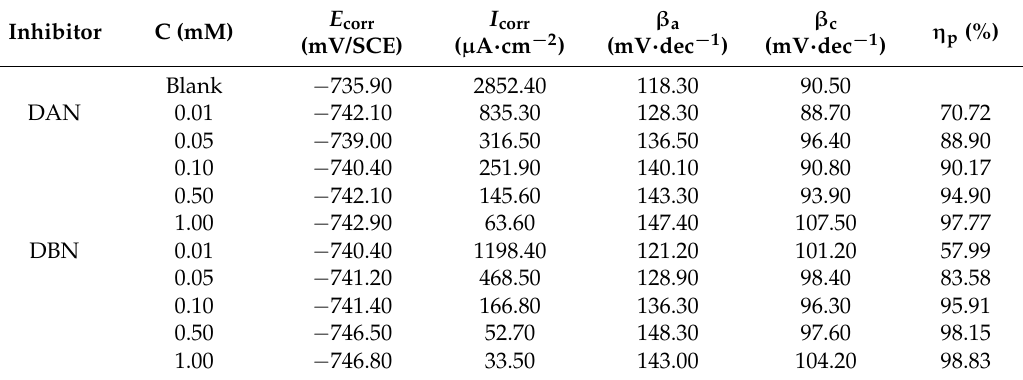
Table 2. Tafel polarization parameters of the corrosion for aluminum alloy in 1 M HCl containing different concentrations of DAN and